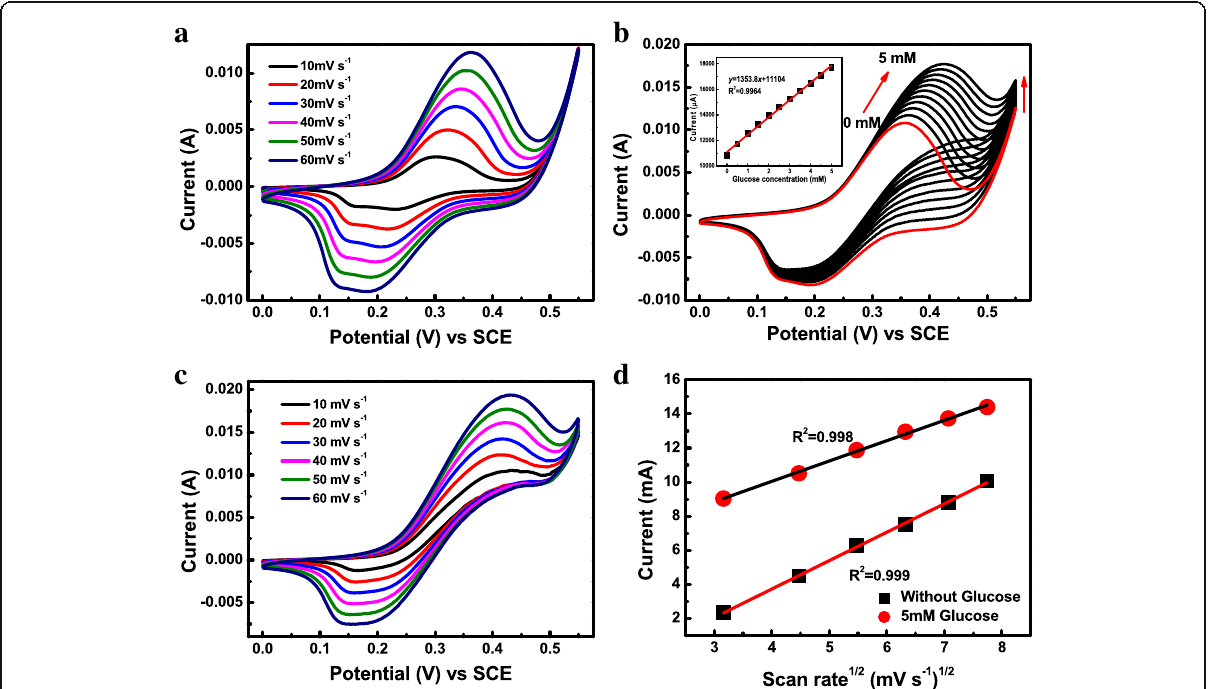
Fig. 3 Electrochemical behaviors of amorphous Co-Ni hydroxide toward glucose oxidation in 0.5 M NaOH. a CV curves at various scan rates in the absence of glucose. b CV curves of the Co-Ni hydroxide electrode with different concentrations of glucose at a scan rate of 50 mV s − 1 . c The CV curves of glucose oxidation at different scan rates from 10 to 60 mV in the presence of 5 mM glucose. d The fitting plots of I pa - ν 1/2 in the absence and presence of